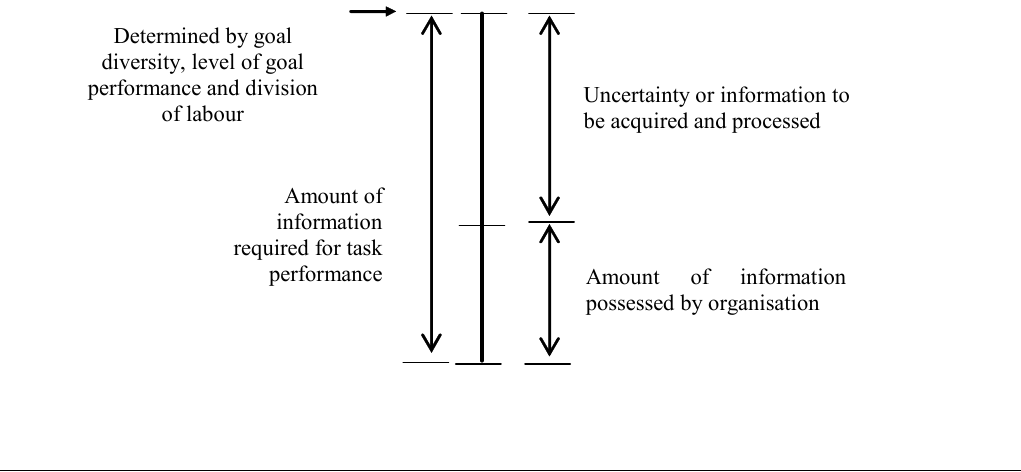
Source: Galbraith (1977) Figure 3: Determinants of information and task